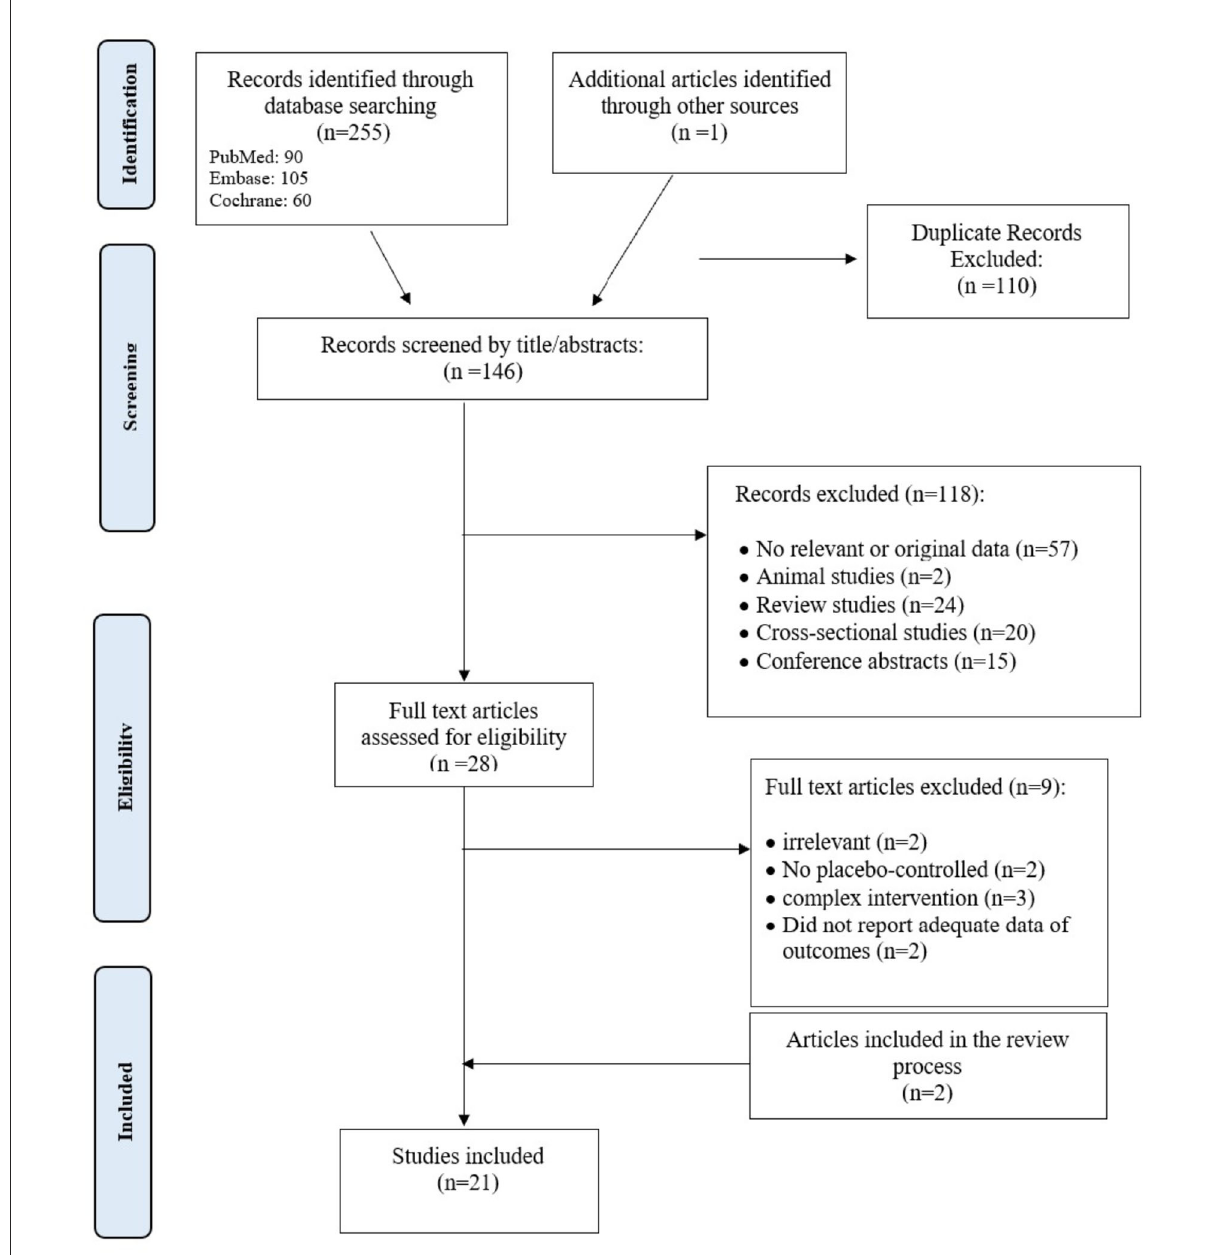
FIGURE1 Flow chart of the number of studies identified and selected into the systematic review and meta-analysis.